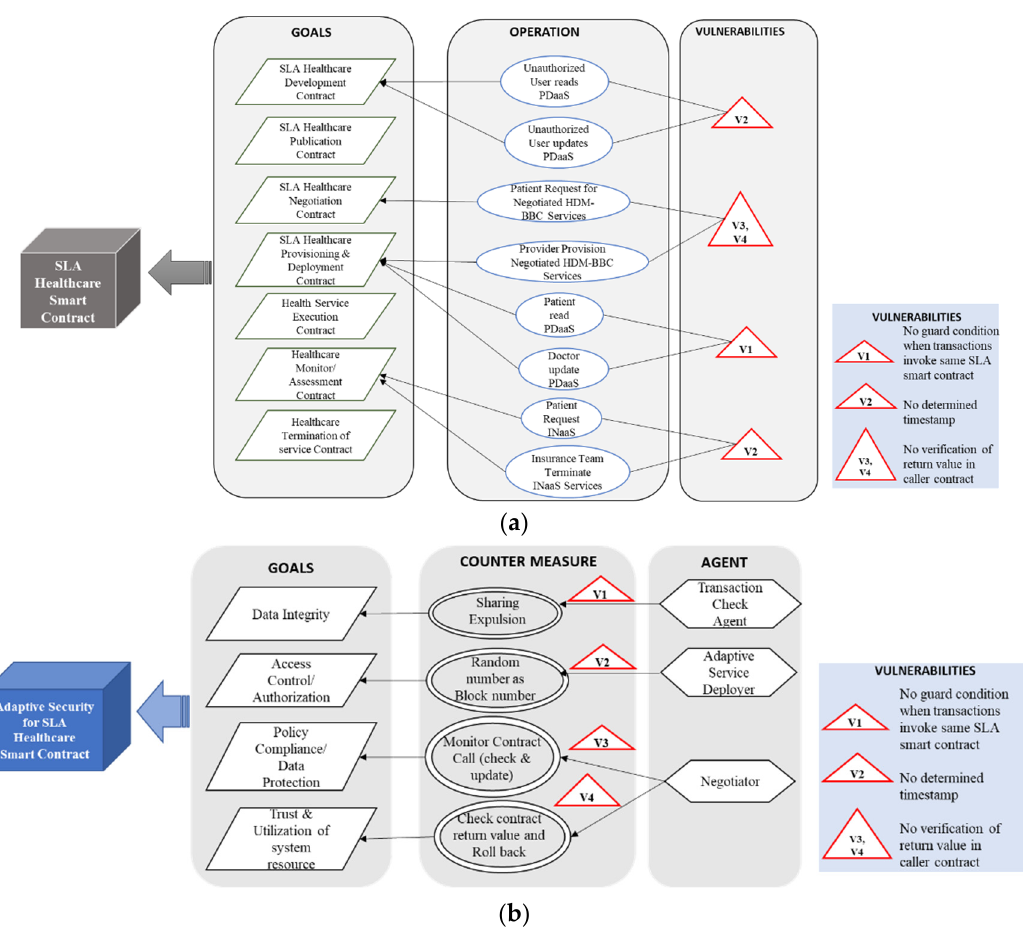
Figure 10. Threat model for reentrancy vulnerability scenario 4: compromised trust and system re- sources.